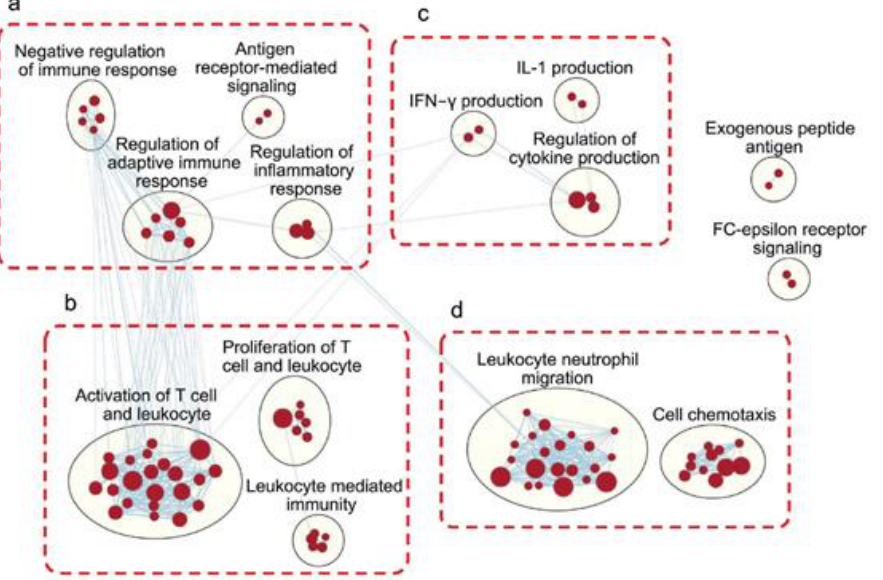
Figure 6. Upregulation of immune response-related pathways in the thyroid of Xb130 − / − mice at W12.